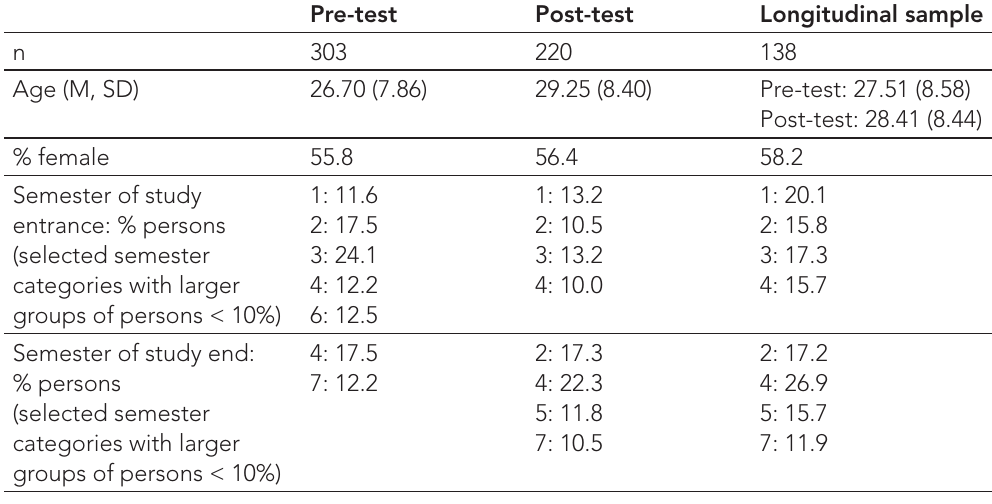
Table 1: Descriptive data of the three